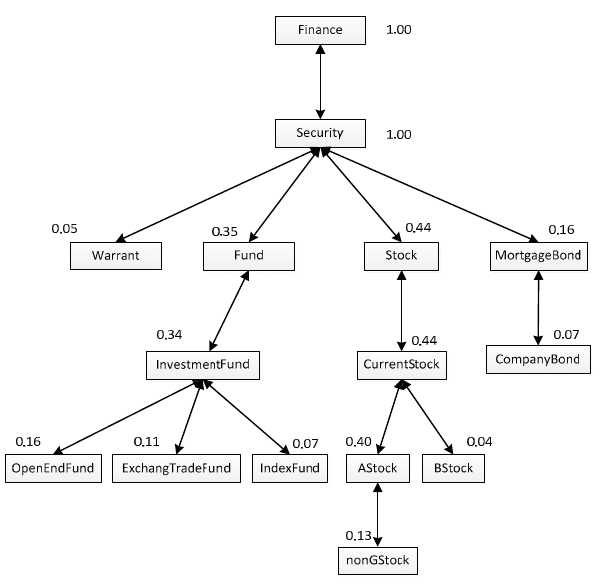
Figure 2. The user personalization model of u a .